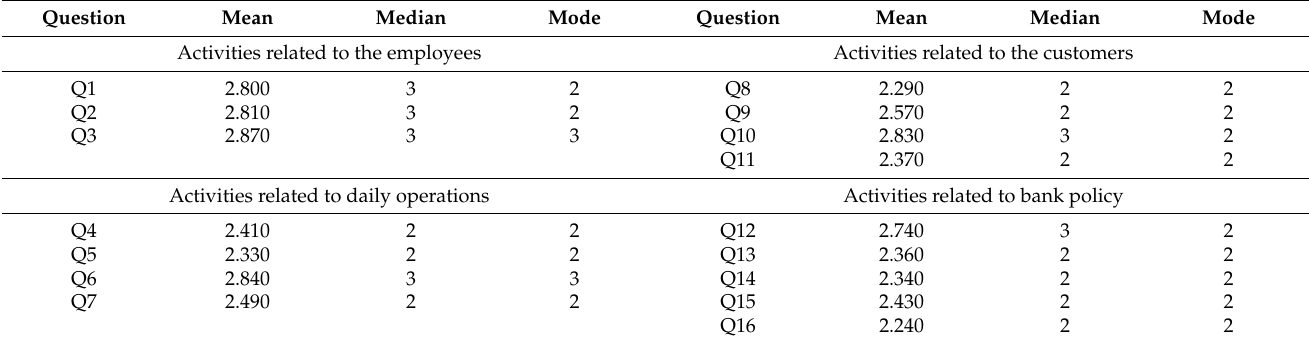
Table 2. The descriptive statistics of data related to the green banking